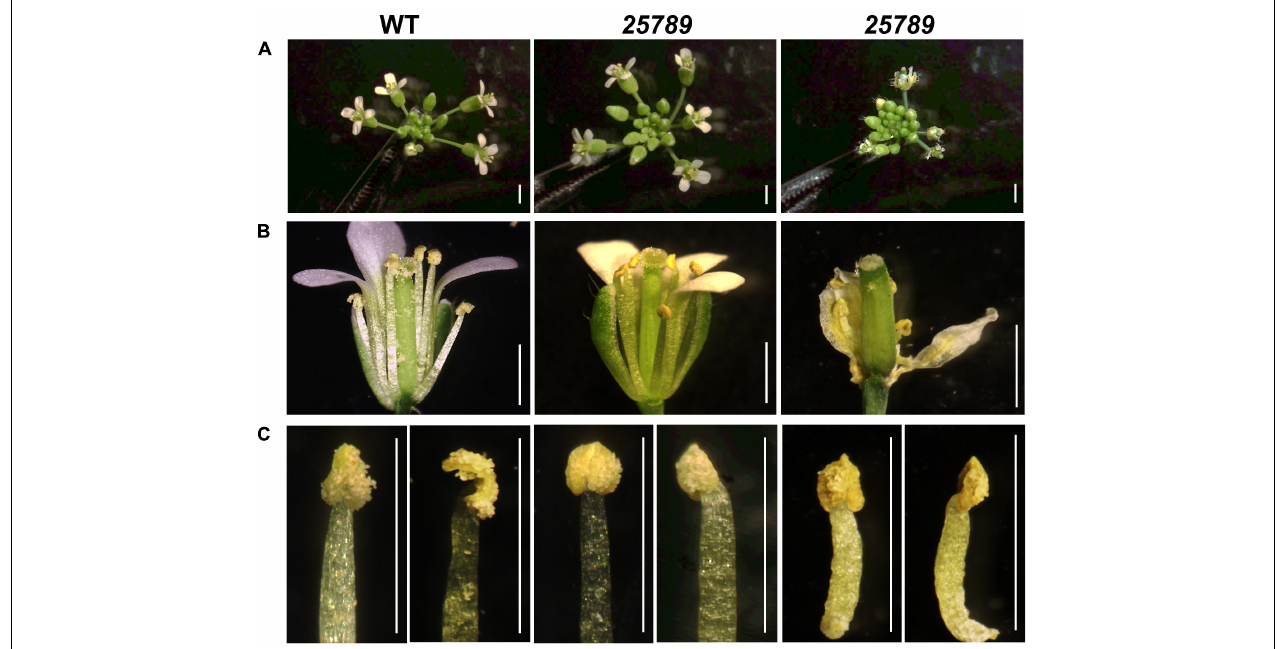
FIGURE 1 | Comparison of the WT and Hyp-GALT galt25789 quintuple mutant inflorescences and stamen. (A) WT and galt25789 quintuple mutant inflorescences. (B) Comparison of stage 13 flowers of the WT and galt25789 quintuple mutants. Normal inflorescences were accompanied by withered/stunted inflorescences in galt25789 mutants. Note, the galt25789 mutant flowers have reduced amount of pollen sticking to the style and stigma. (C) Anther morphology of stage 13 flowers of the WT and galt25789 quintuple mutants with front view and side view, respectively. Scale bar = 1.0 mm.